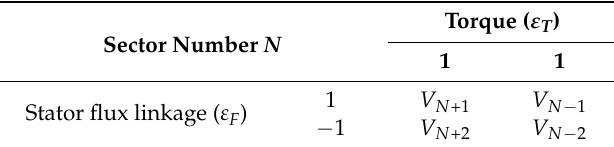
Table 1. Conventional switching table.